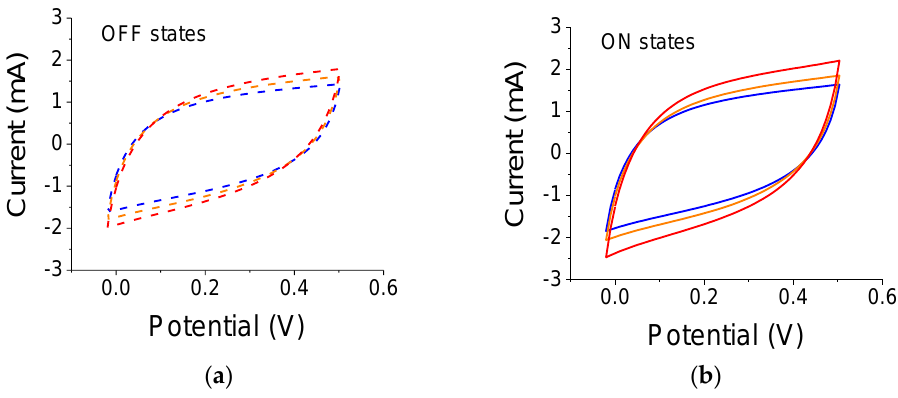
Figure 5. ( a ) Light OFF, C-V reference curves for 0.2 µm particles measured before each illumination by a 75 W white-light source. Experiments were carried out after the conclusions of the experiments with the 300 W lamp. The colored dashed curves correspond to successive references for data taken